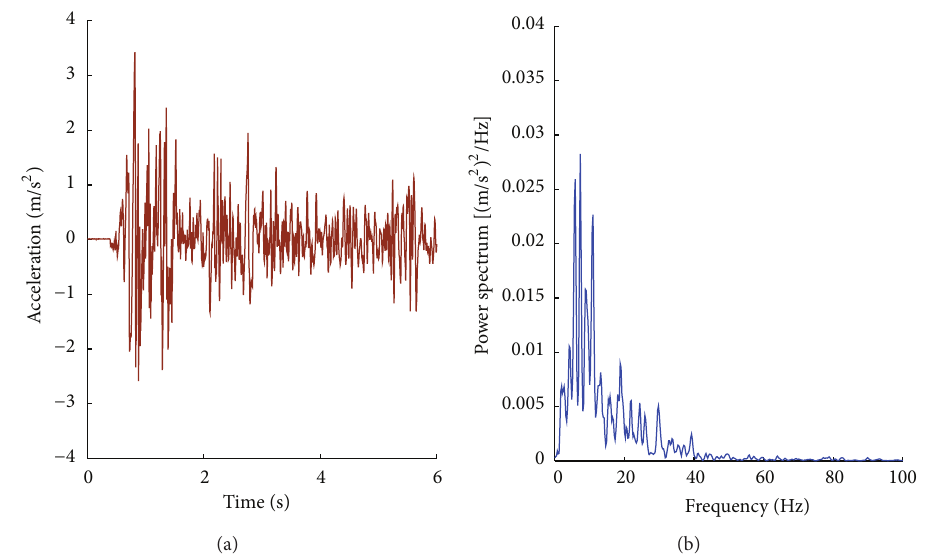
Figure 6: Time history (a) and power spectrum (b) of the input ground acceleration.